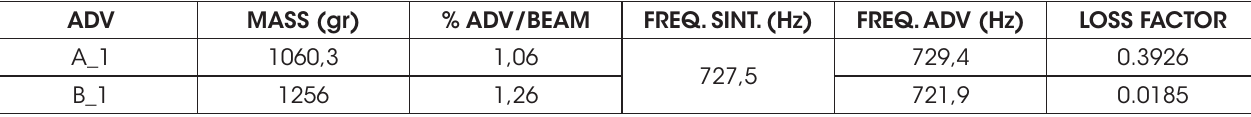
Constructive parameters of